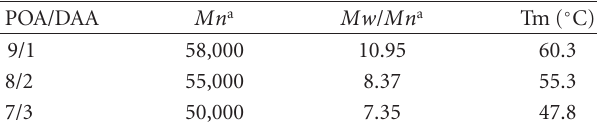
Table 3: The P(POA- r -DAA)